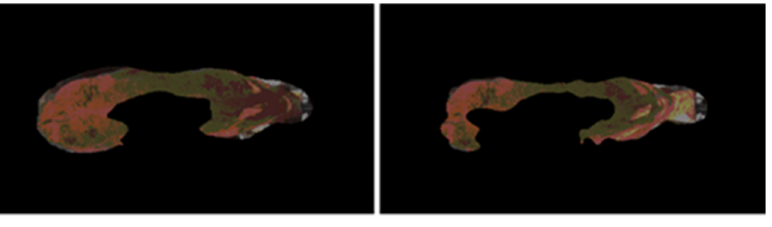
Figure 8. Grad-CAM